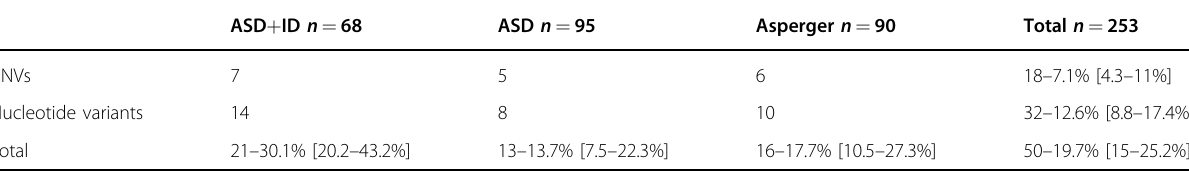
Table 4 Detection rate for CNVs and nucleotide variants among the 253 ASD subjects strati fi ed by clinical